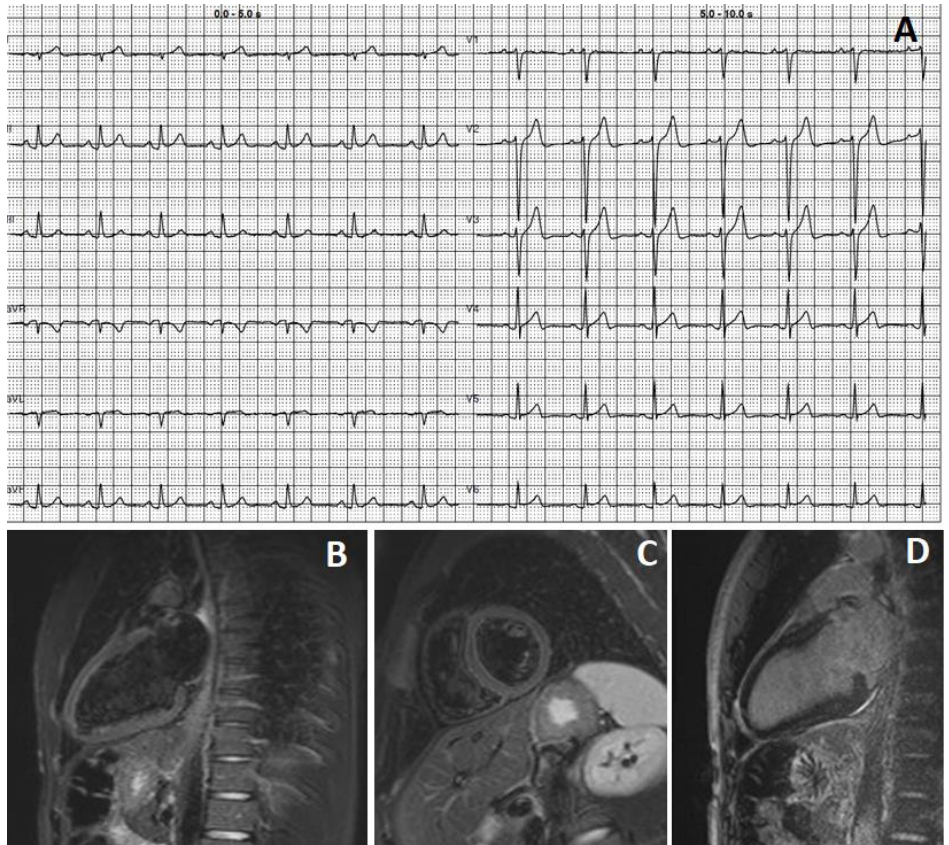
Figure 2. ( A ) ECG showing sinus rhythm, mild ST-segment elevation, and diphasic T waves. ( B – D ): T2-weighted short-tau inversion recovery (T2 STIR) sequences showing oedema of anterolateral myocardial segments with streaky late gadolinium enhancement involving the lateral left ventricular wall.